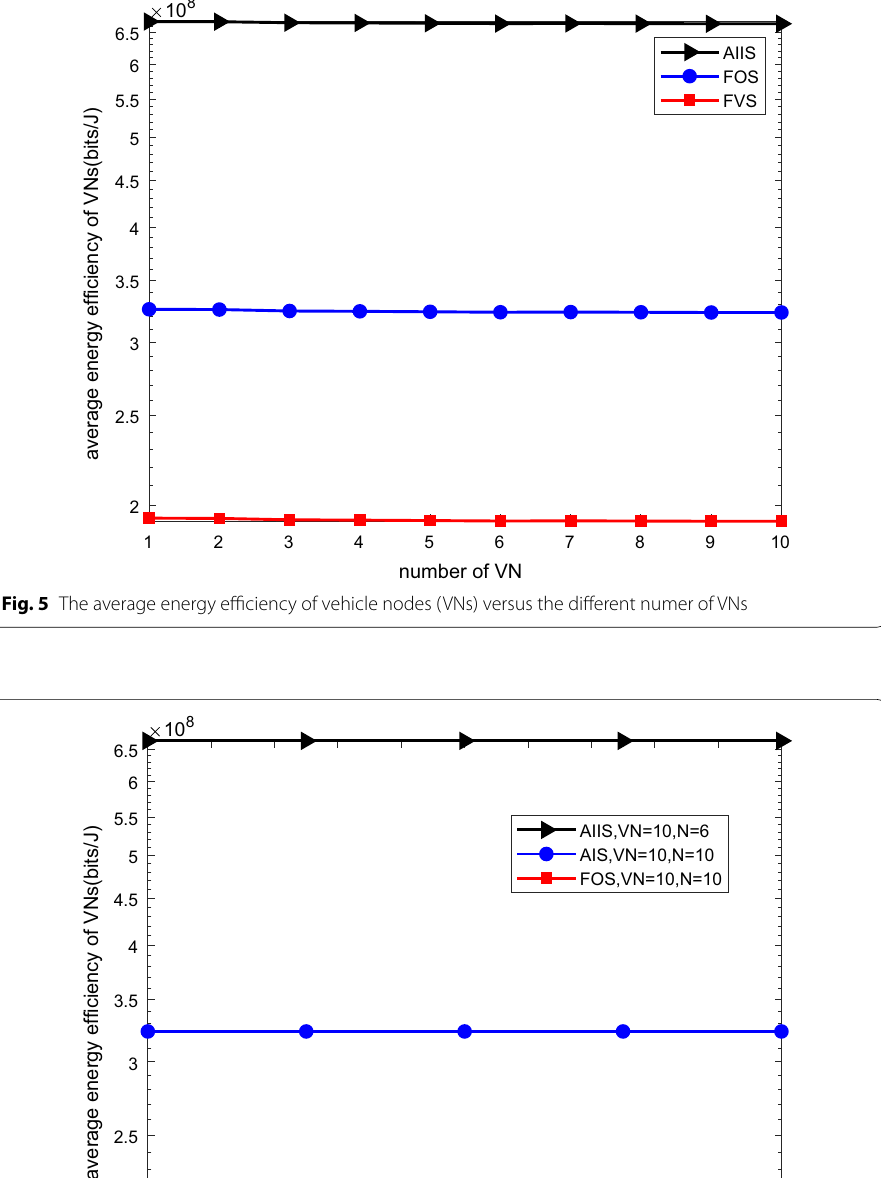
vehicles can be guranteed. For the latter, the proposed scheme has the lower variance of transmission time consumptions between all vehicles with the same computation tasks comparing with the benchmark schemes, which indicates that the time-latency fairness between the different vehicles of AIIS is superior to that of the comparing schemes.